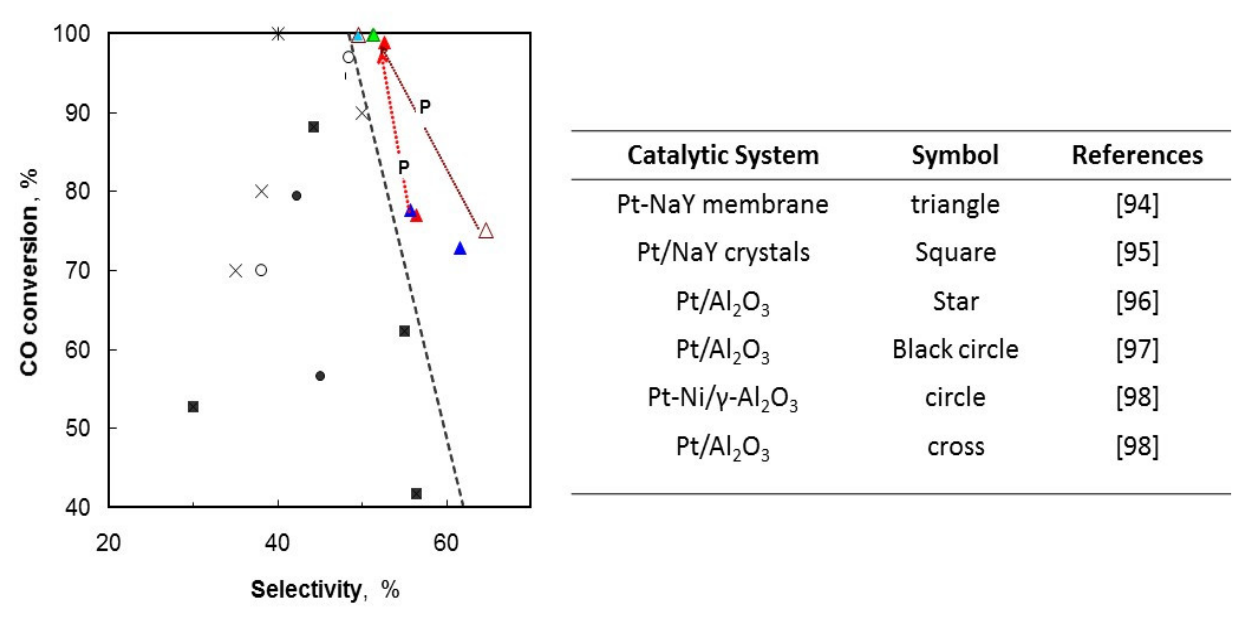
Figure 7. Comparison between Pt-NaY zeolite CMR and traditional reactors for the CO SelOx [94–98].